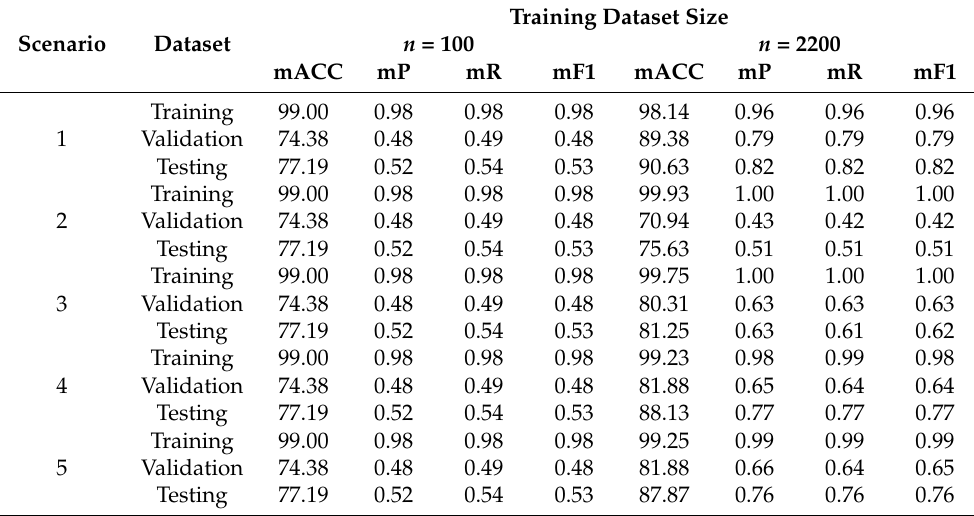
Table 4. Comparison of performance indicators for training, validation, and testing datasets for different training dataset